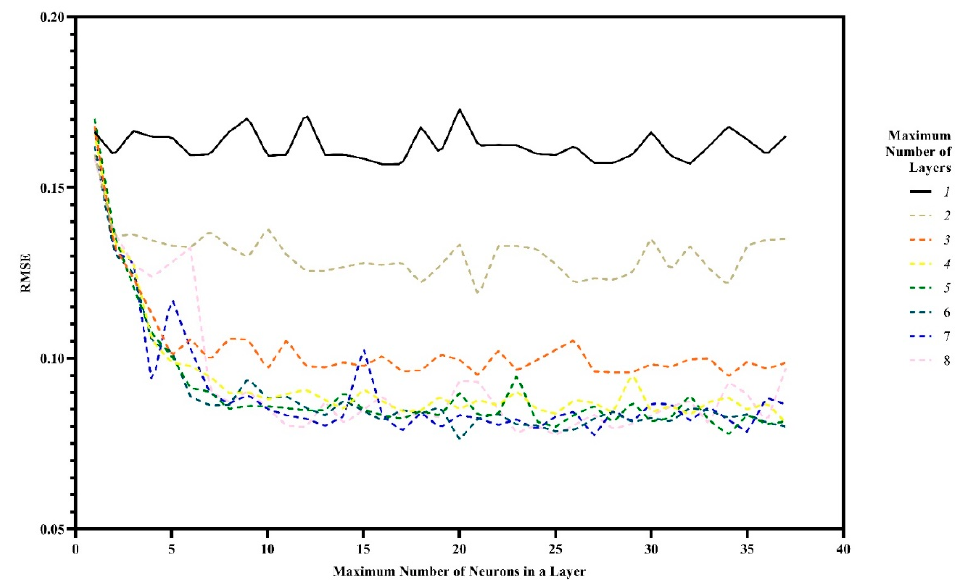
Figure 8. GMDH: dependence of the RMSE at the end of training on the maximum number of neurons in a layer and on the maximum number of layers in the ANN.